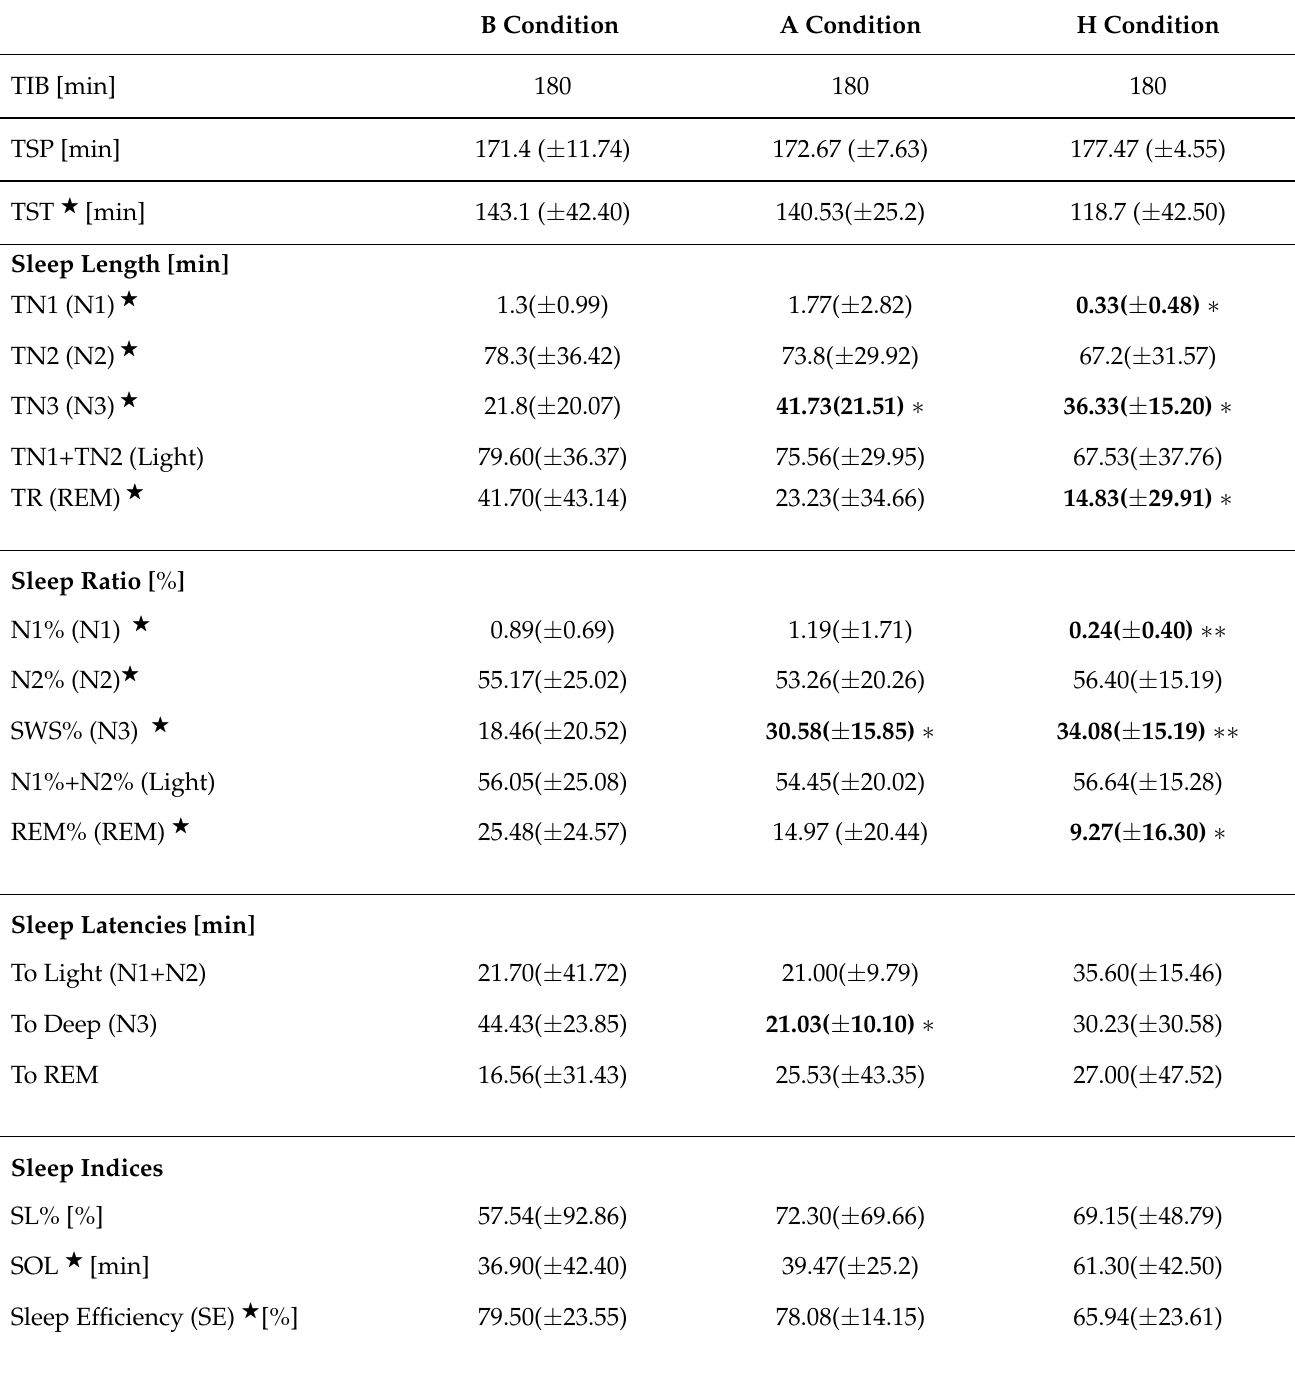
Table 2. Sleep parameters in each experimental condition for the whole nap time of sleep analysis; Time in Bed is calculated from light-off; TSP, TST, and sleep latencies are calculated from the first N1 period (>1